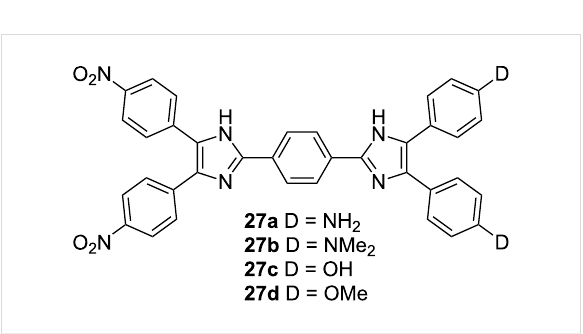
Figure 9: Typical D- π -A diimidazole CT chromophore